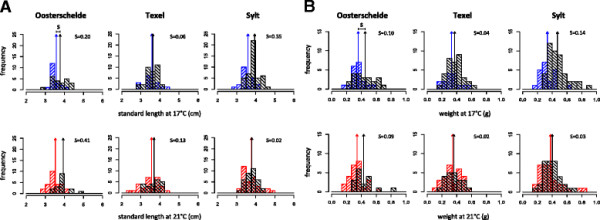
Selection gradients of life history traits under pathogen induced selection. Length (A) and weight (B) of dead fish (red bars = died at 17°C, blue bars = died at 21°C) and surviving fish (black bars) from different populations. Arrows show the means of the respective distributions marking the selection differential S (mean trait survived - mean trait dead) resulting from pathogen-induced mortality. Only data from infected fish were used for selective gradients.